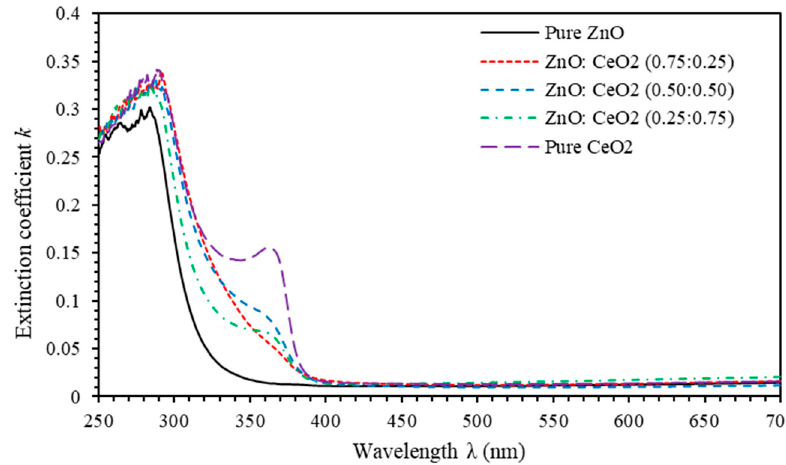
Figure 8. The Extinction coe ffi cient k spectra of pure ZnO, pure CeO 2 and ZnO:CeO 2 mixed oxides thin films.